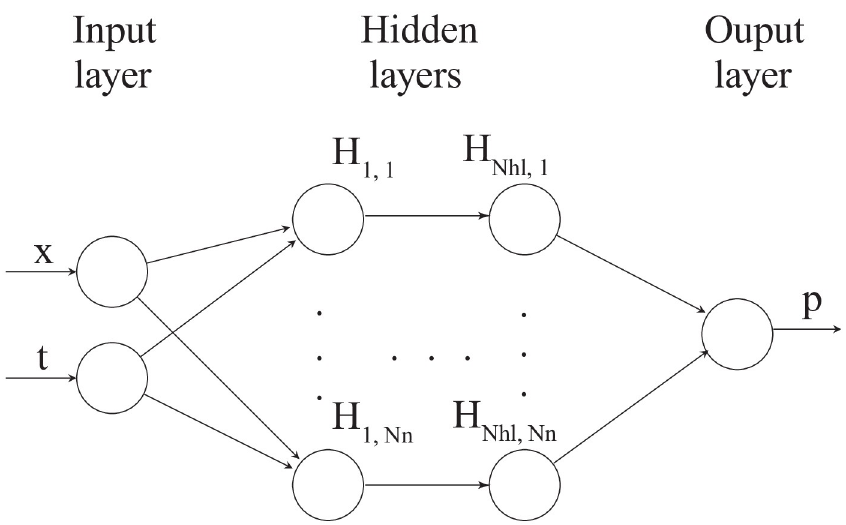
Fig 4. Neural network architecture used for nonlinear diffusivity equation. This network corresponds to the top part of Fig 3. There are two input nodes, x and t , and one output node, p . The number of hidden layers, N number of neurons for each hidden layer, N n , denote the